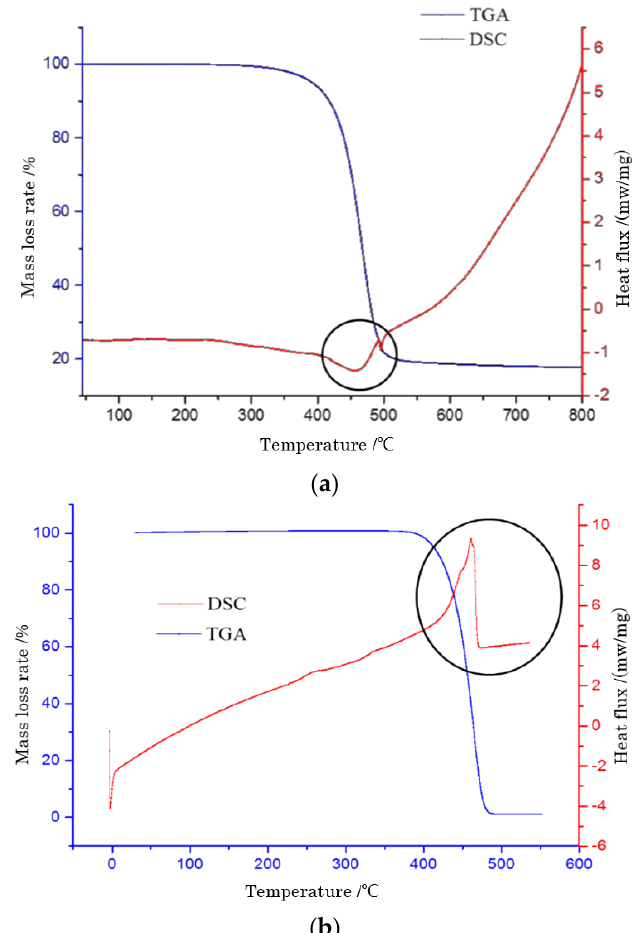
Figure 9. TG-DSC spectrum of base asphalt and PE-modified asphalt. ( a ) TG-DSC spectrum of base asphalt. ( b ) TG-DSC spectrum of PE modified asphalt.